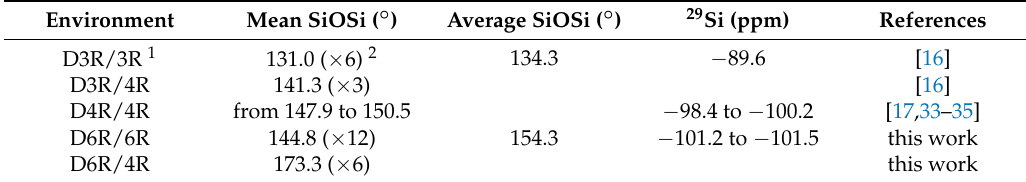
Table 3. Mean SiOSi bond angles in D n R silicate compounds and 29 Si NMR data.